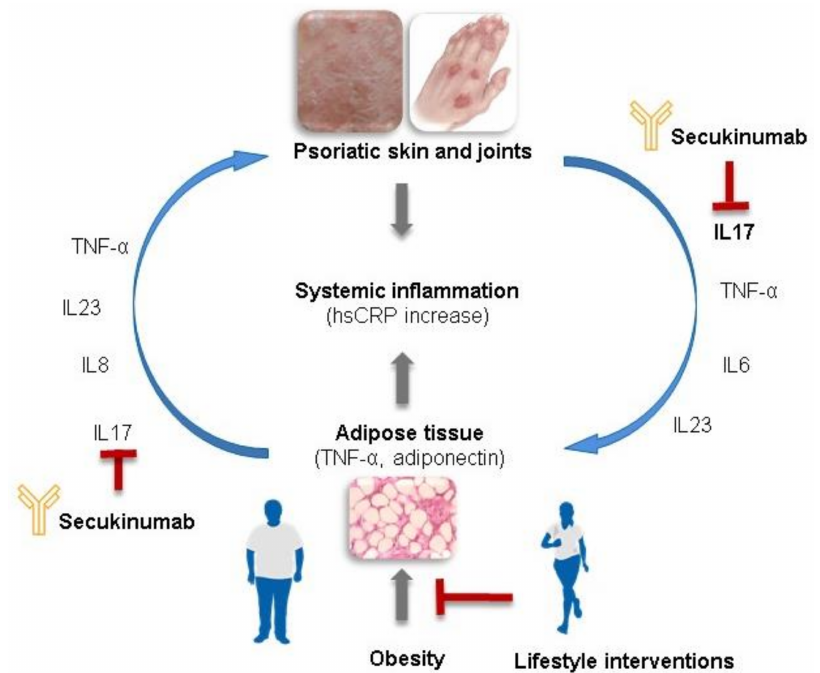
Figure 1. Pathophysiology of psoriasis and obesity. The pathophysiological processes of systemic inflammation that underlie psoriasis and obesity/metabolic syndrome are interconnected via the release of inflammatory mediators from both psoriatic lesions and adipose tissue. IL-17 blockade with secukinumab inhibits aspects of this inflammatory cycle, but lifestyle interventions aimed at reducing obesity and associated inflammation may produce synergistic effects.hsCrp, high-sensitivity C-reactive protein; IL, interleukin; TNF, tumour necrosis